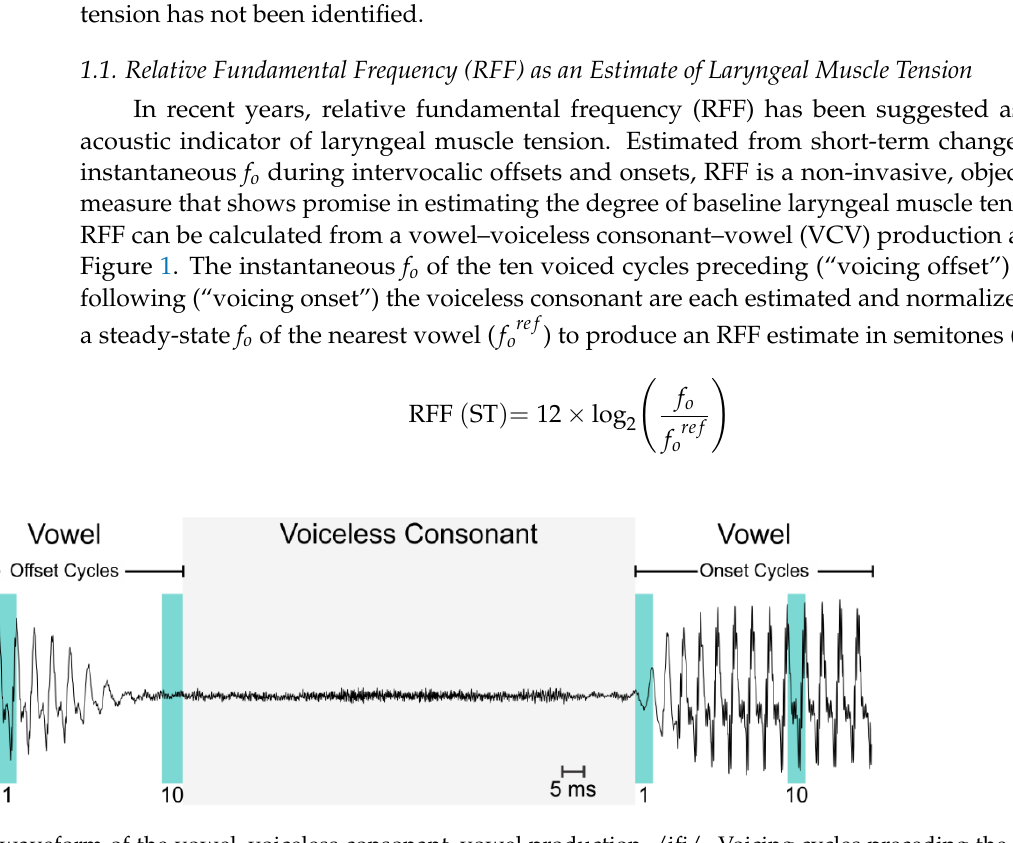
Figure 1. Acoustic waveform of the vowel–voiceless consonant–vowel production, /ifi/. Voicing cycles preceding the voiceless consonant, /f/, are marked as voicing offset cycles, whereas those following the /f/ are indicated as voicing onset cycles. The first and tenth vocal cycles are highlighted for each